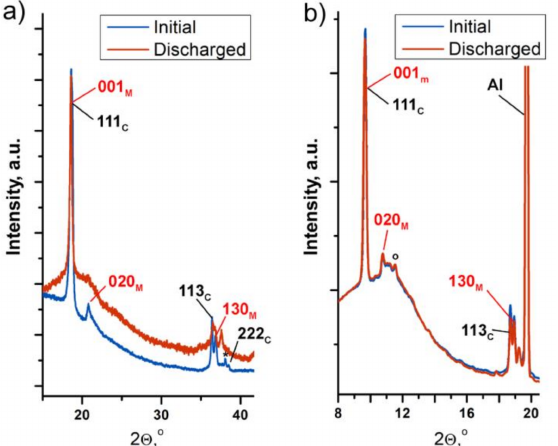
Figure 6. PXRD patterns of the Li 2 Ni 0.5 Mn 1.5 O 4 electrode at the initial state and after the first charge– discharge cycle collected by means of laboratory ( a ) and synchrotron ( b ) XRD. Reflections of the monoclinic Li(Li 0.28 Mn 0.64 Ni 0.08 )O 2 phase are marked in red; those for the cubic spinel are in